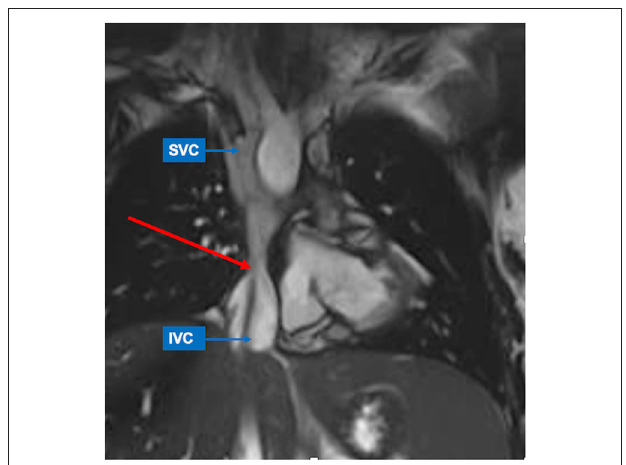
FIGURE 2 | Inferior caval vein (IVC)-to-pulmonary artery stenosis (red arrow) seen by CMR. SSFP-coronal view demonstrates focal stenosis of the IVC-to-pulmonary artery pathway (red arrow). The superior caval vein (SVC) shows normal size.